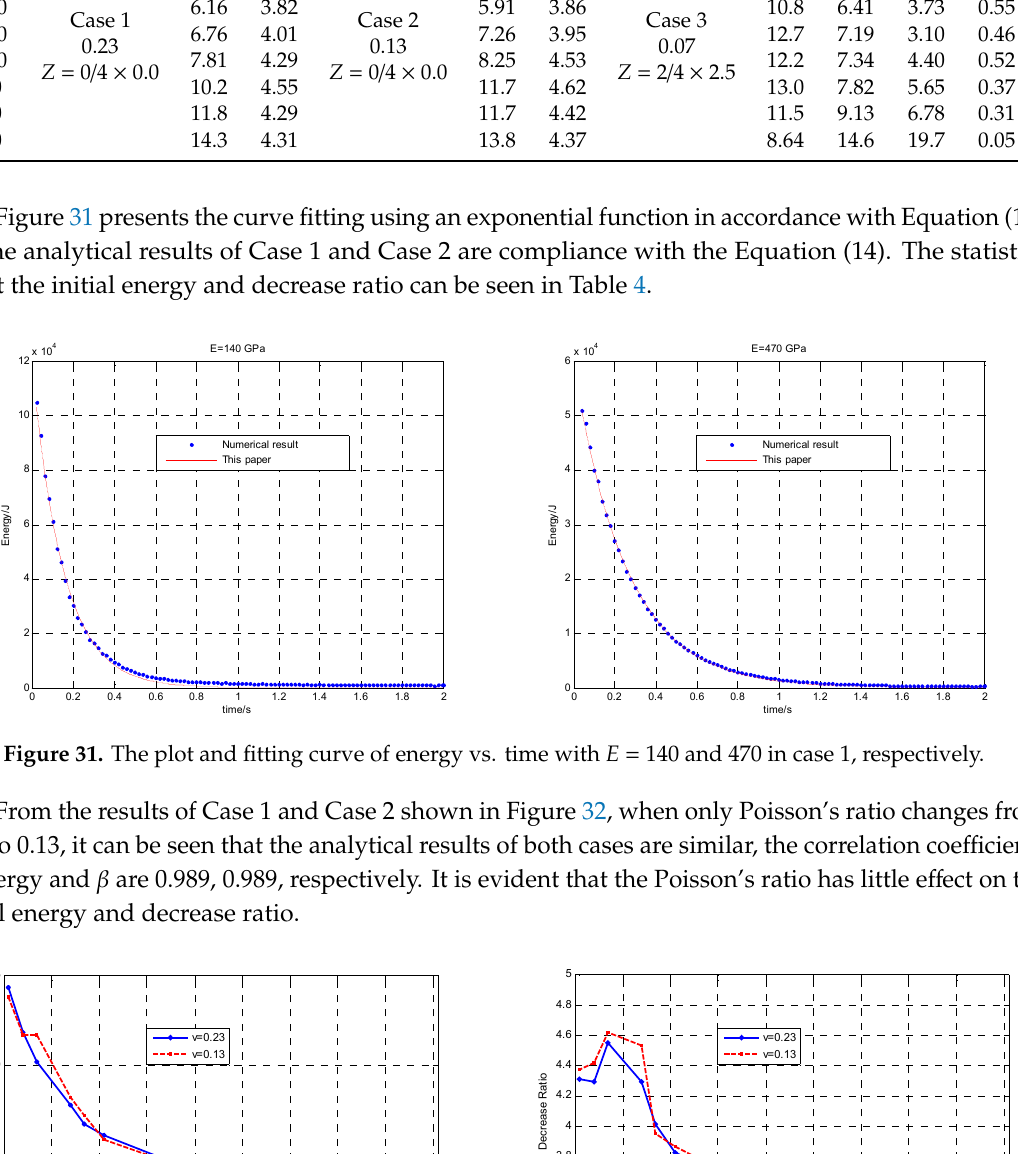
Table 4. The initial total energy ( × 10 4 J) and the ratio β at di ff erent E and υ , with R = 5, L = 30.